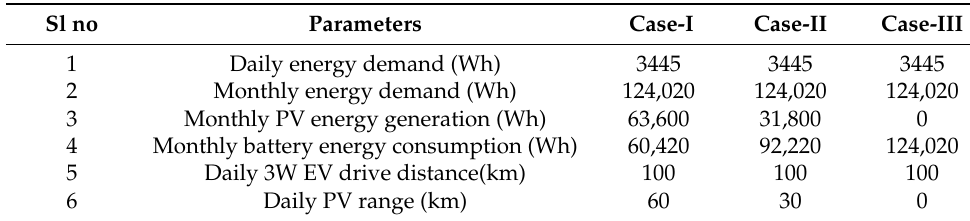
Figure 6. Irradiance (blue), ambient temperature (red). Table 3. Cases of electric vehicle